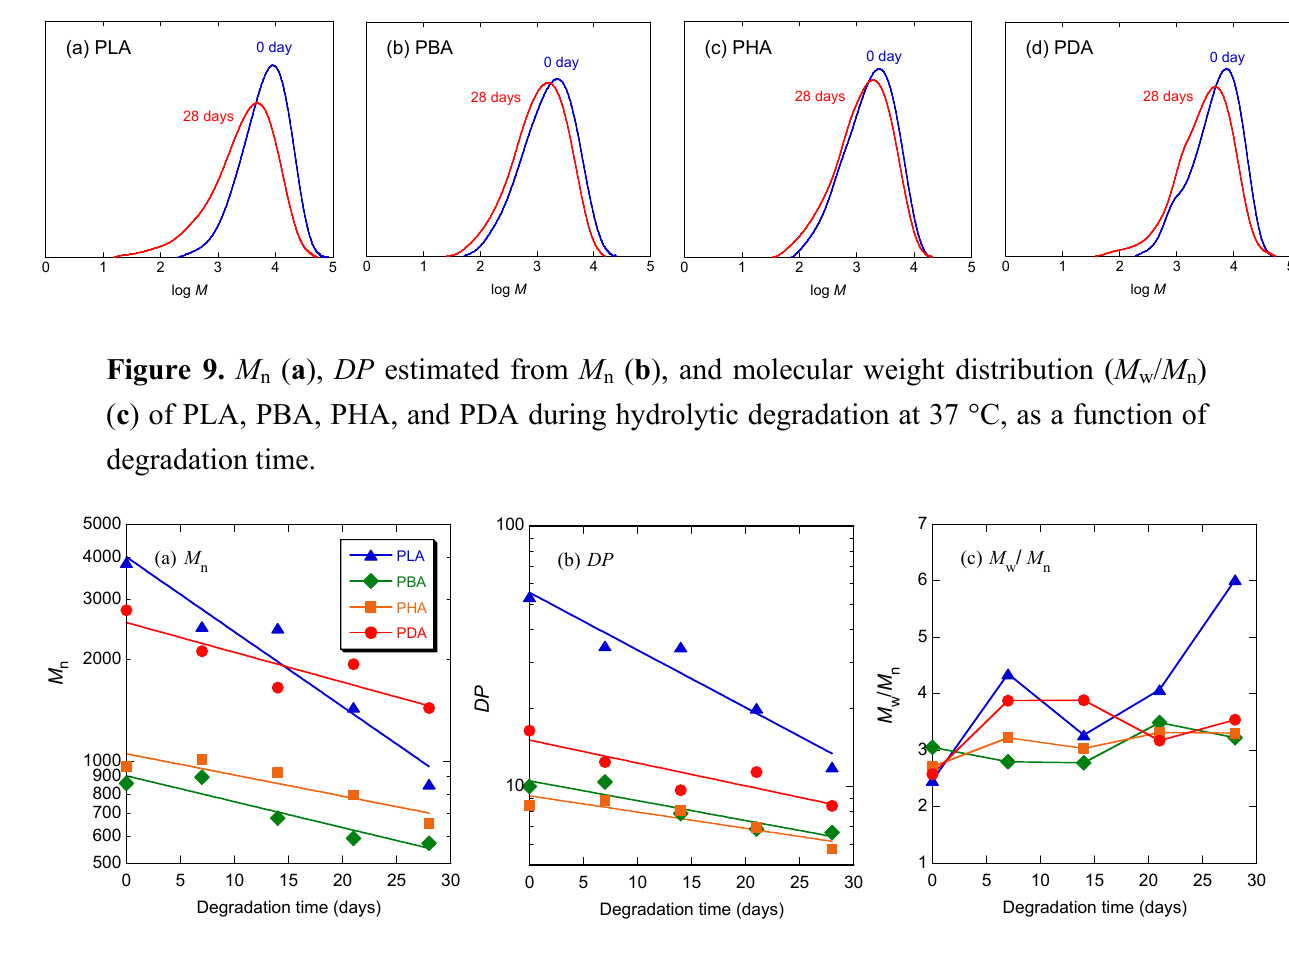
Figure 8. Molecular weight distribution curves of PLA ( a ), PBA ( b ), PHA ( c ), and PDA ( d ) before hydrolytic degradation (0 days) and after hydrolytic degradation at 37 °C for 28 days.